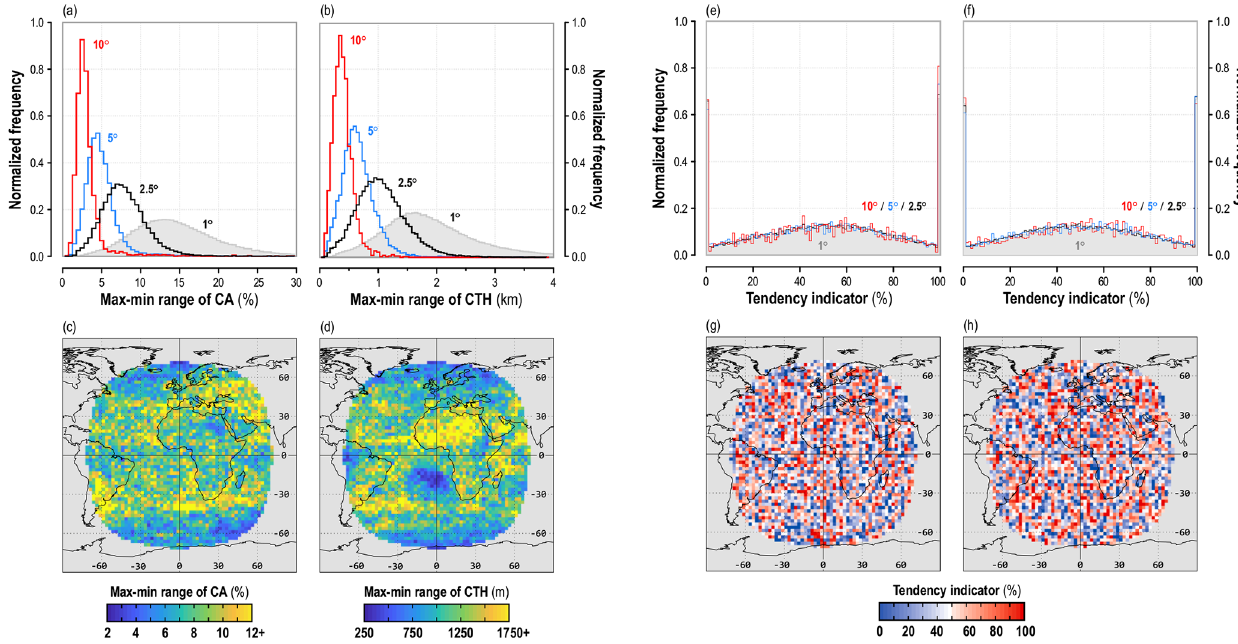
Figure 5. The range between maximum and minimum estimates of mean annual cloud amount (c) , and mean annual cloud top height (d) for all of the possible start dates for the CALIPSO ground track. The tendency for a parameter in the CALIPSO dataset from the actual launch date to be over- or underestimated is shown in (g) for cloud amount, and (h) for cloud top height. Maps (c) , (d) , (g) , and (h) only refer to the simulated 2.5 ◦ resolution CALIPSO dataset for 2008. Plots (a) , (b) , (e) , and (f) cover all resolutions